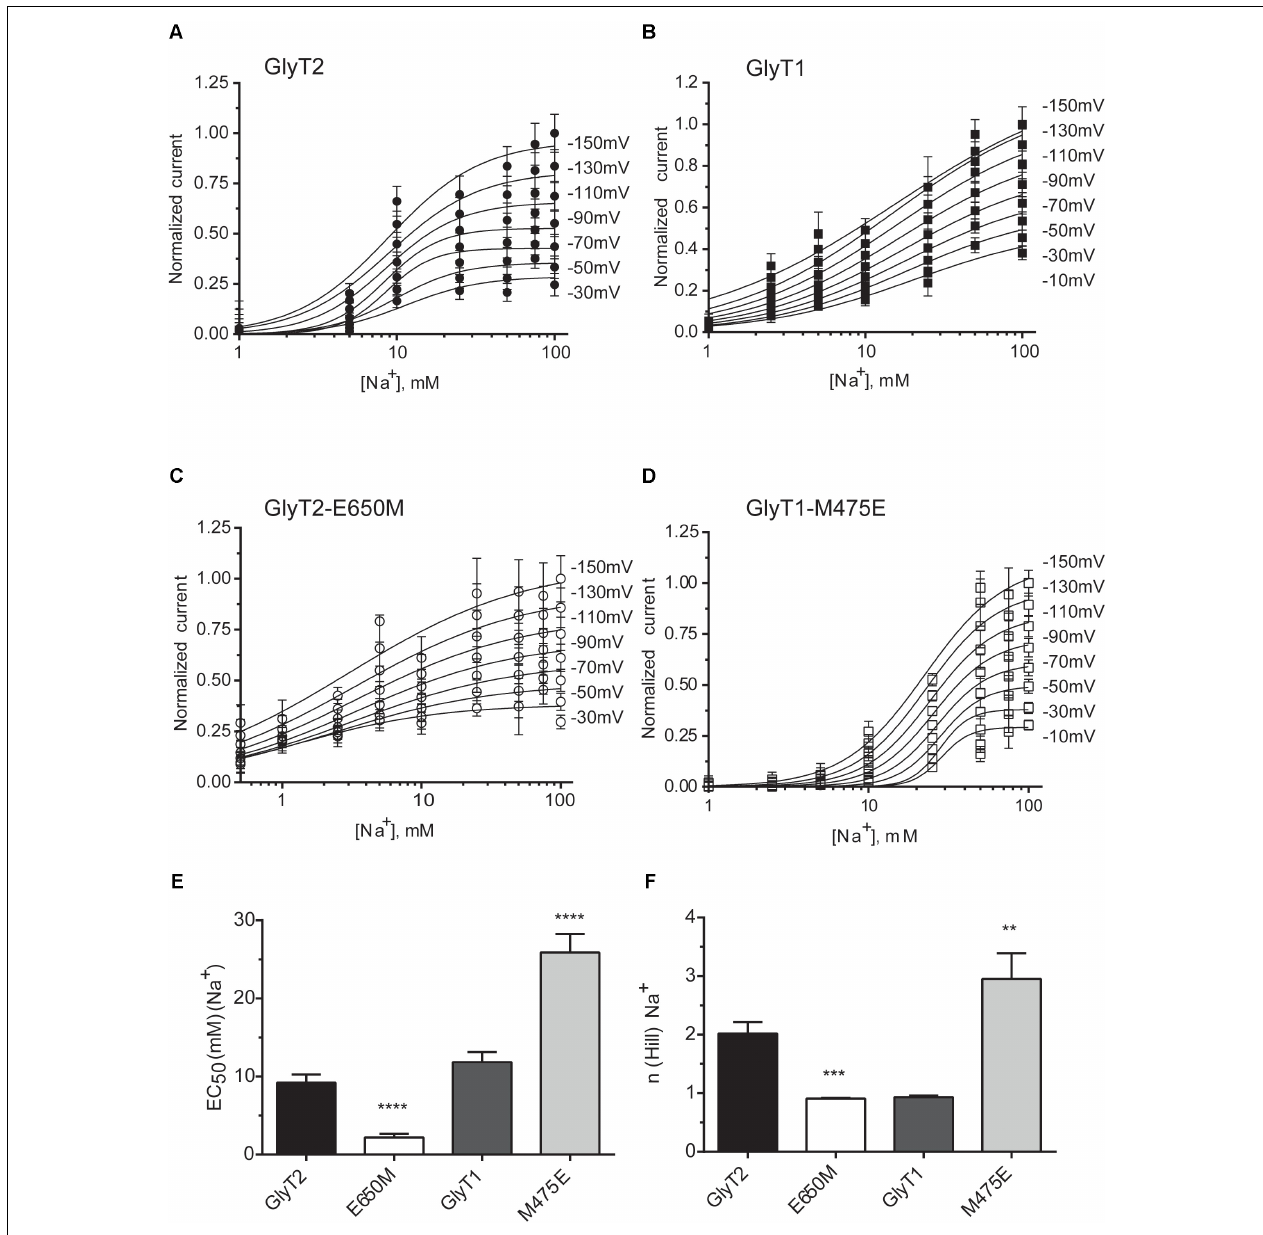
FIGURE 5 | Sodium dependence of glycine-evoked steady-state currents in the oocytes expressing GlyT2 and GlyT1 wild-type and mutants. (A–D) At least six oocytes expressing the indicated transporters were voltage-clamped at the specified clamping potentials over the range of –150 and –10 mV and glycine-induced currents at increasing external sodium concentrations (choline substitution) were measured to estimate the EC 50 (E) and Hill coefficient (F) . At each potential glycine-induced currents were averaged and normalized to those at –150 mV. Data were analyzed by paired t -test, comparing with wild-type GlyT1 or wild-type GlyT2. ∗∗ p < 0.01; ∗∗∗ p < 0.001; ∗∗∗∗ p < 0.0001.